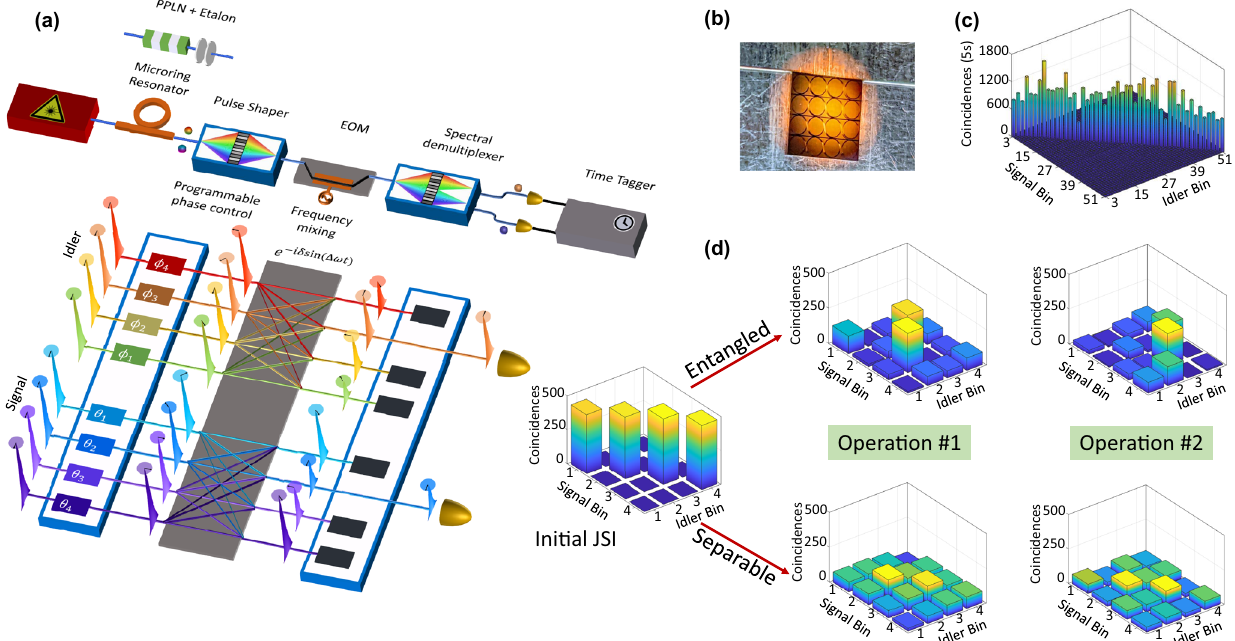
Fig.1|Illustrationofourproposedscheme.a Experimentalsetupandconceptual illustration. A random operation is uniquely determined by the d random spectral phases θ m ( ϕ m ) on the signal (idler) bins and the EOM modulation index δ . b Microscope image of the MRR chip. The device in the last column of the second